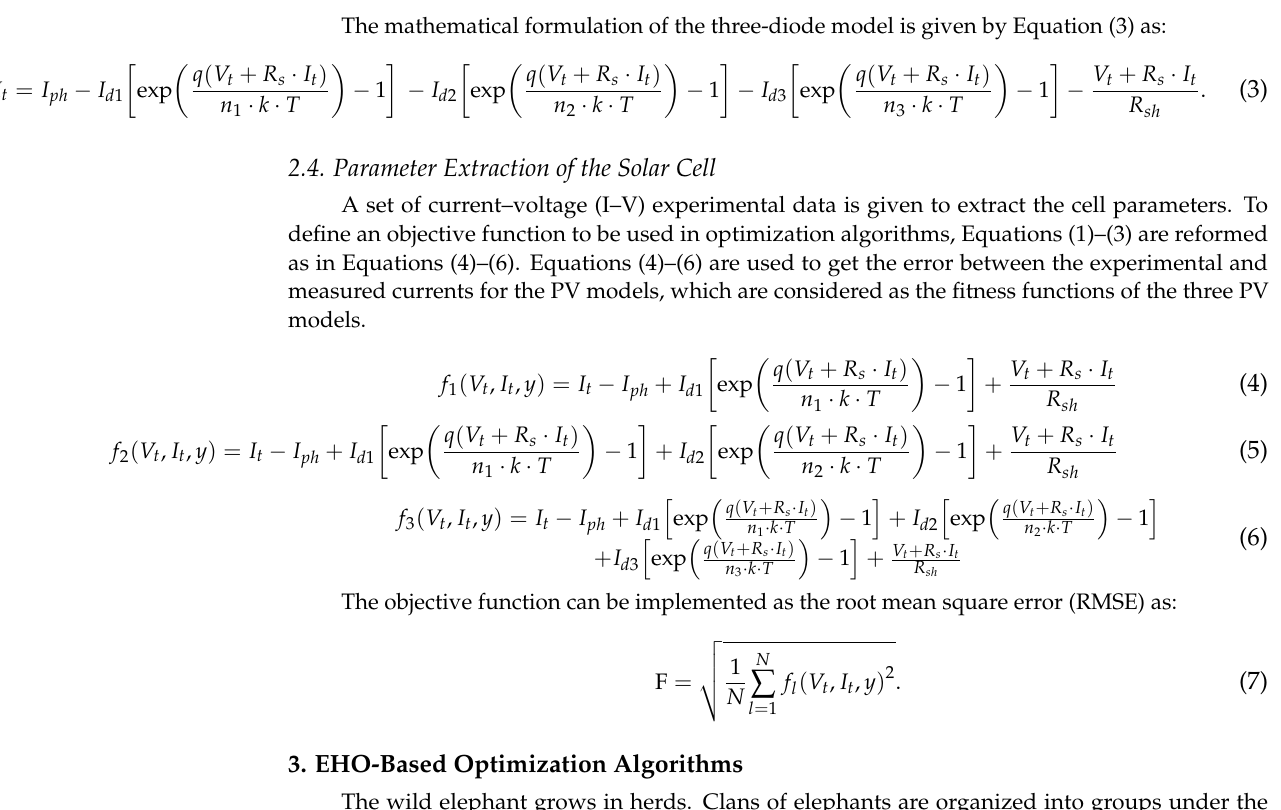
Figure 3. Three-diode